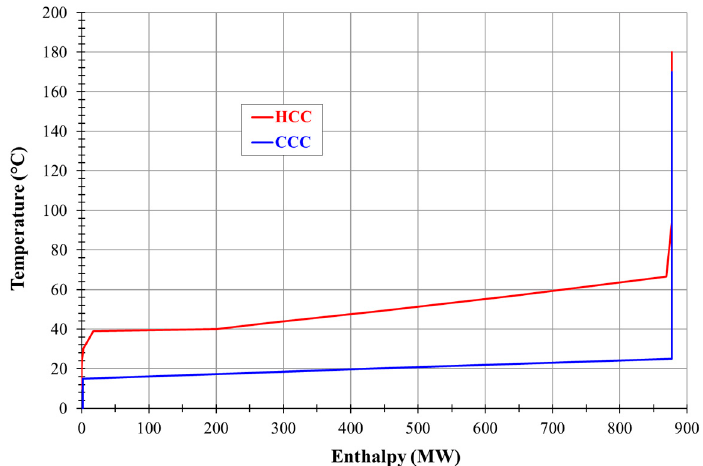
Figure 8. Thermal integration analysis for MDEA-based CO 2 capture unit.